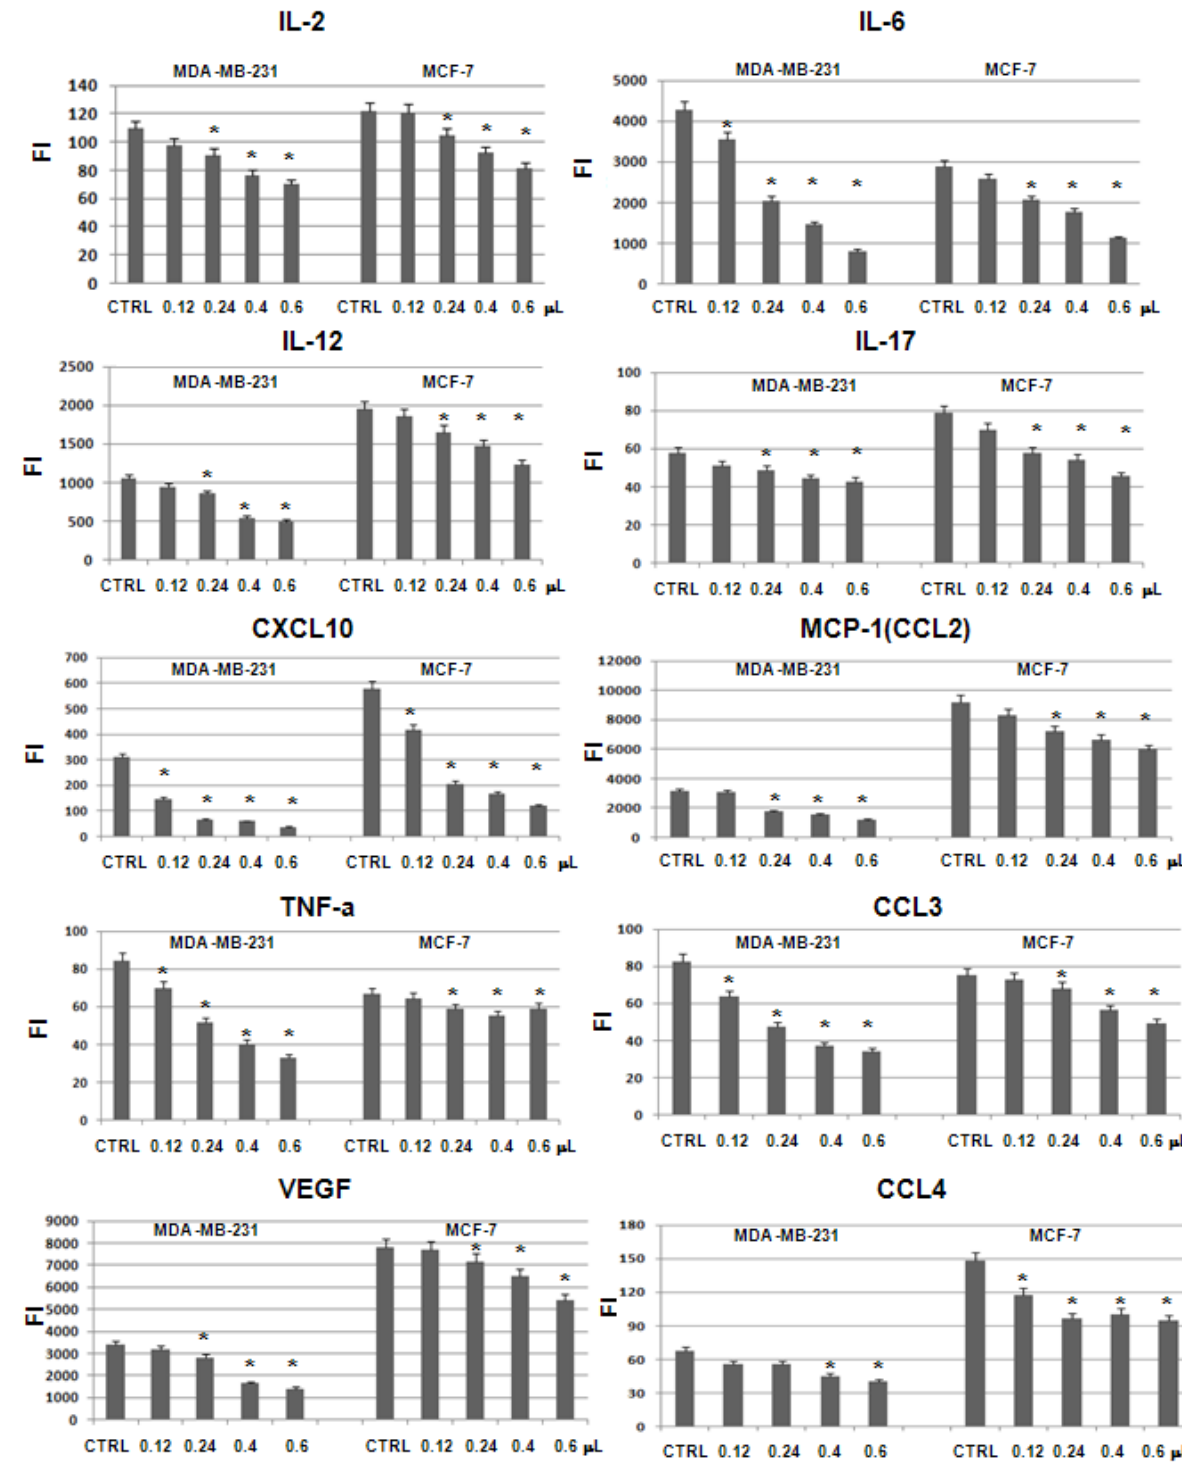
Figure 4. Cytokine levels (expressed as fluorescence intensity) evaluated in MCF-7 and MDA-MB-231 cells after treatment with hydrophilic extracts of PSO performed in triplicate. We indicate with * the comparisons between the levels in the untreated and treated cells that resulted statistically significant ( p < 0.05 by